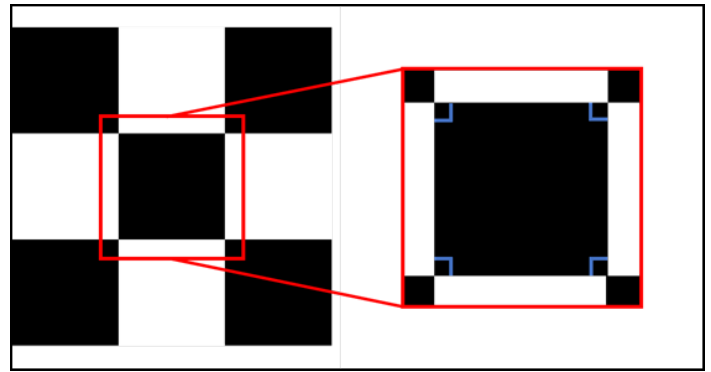
Figure 5. Angles of the four corners in a square without an angle error. The angle of the upper-left corner, which is the inclusive located angle between the upper-right and lower-left corners, shall be measured in the region observed. Then, the angle between the upper-left corner and bottom-right corner shall be calculated. As a result, the angles of all four corners shall be calculated and confirmed as to whether they are 90 degrees. If all the angles are 90 degrees at this point, it shall be determined as a square on the camera calibration board. With this method, the vertices of squares in the entire area on the taken image shall be detected. However, the filming may be done while the camera calibration board is not tilted at all. If a rotation has only occurred on a single axis among x, y, or z, in a three-dimensional environment, as shown in Figure 6a,b, a phenomena occurs when a distortion occurs on the x and y axes. This is distorted in the form of a rectangular shape due to different lengths of the horizontal and vertical axes, and Figure 6c shows the distortion of the angle to the z -axis, resulting in a tilted square resulting in a different reference line for estimating the angle of the square.